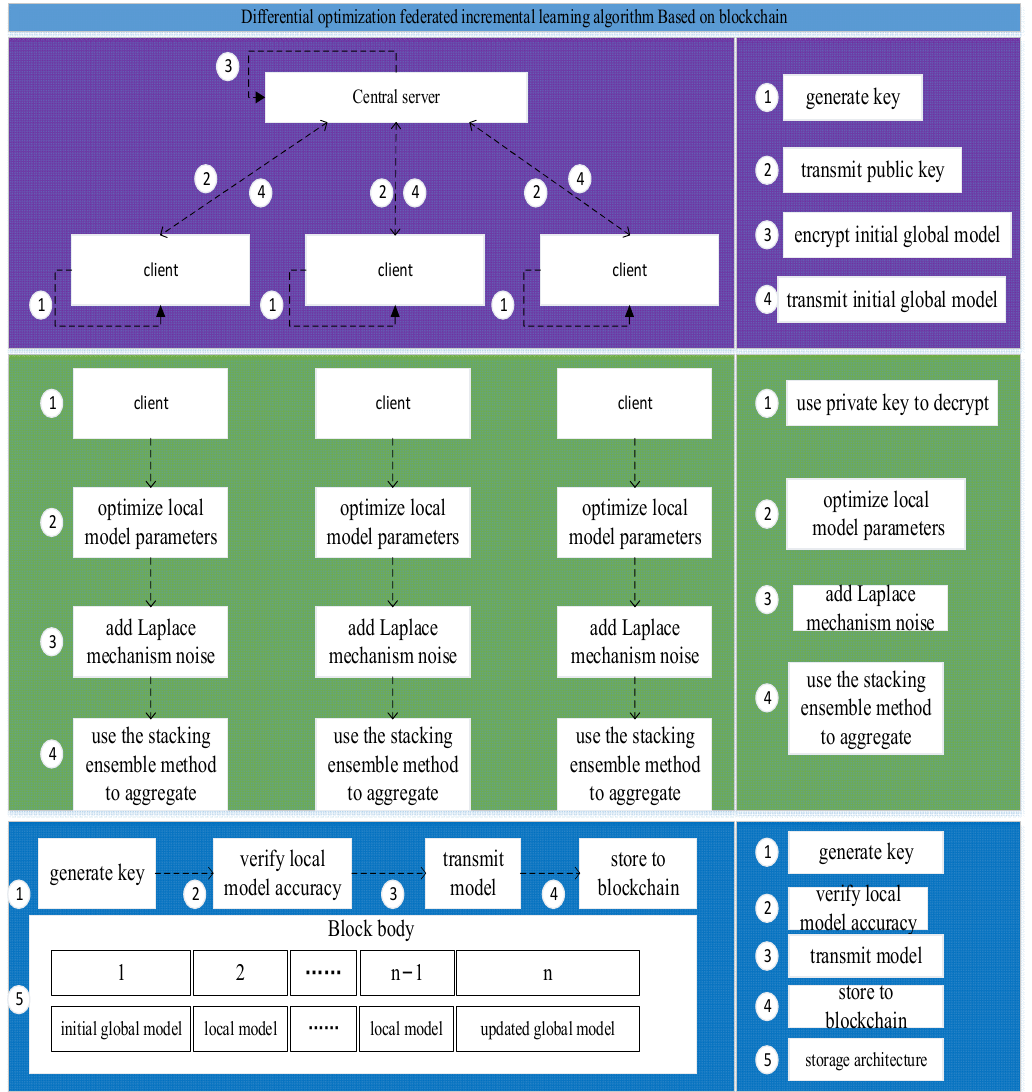
Figure 1. Blockchain-based differential optimization joint incremental learning algorithm frame- work.